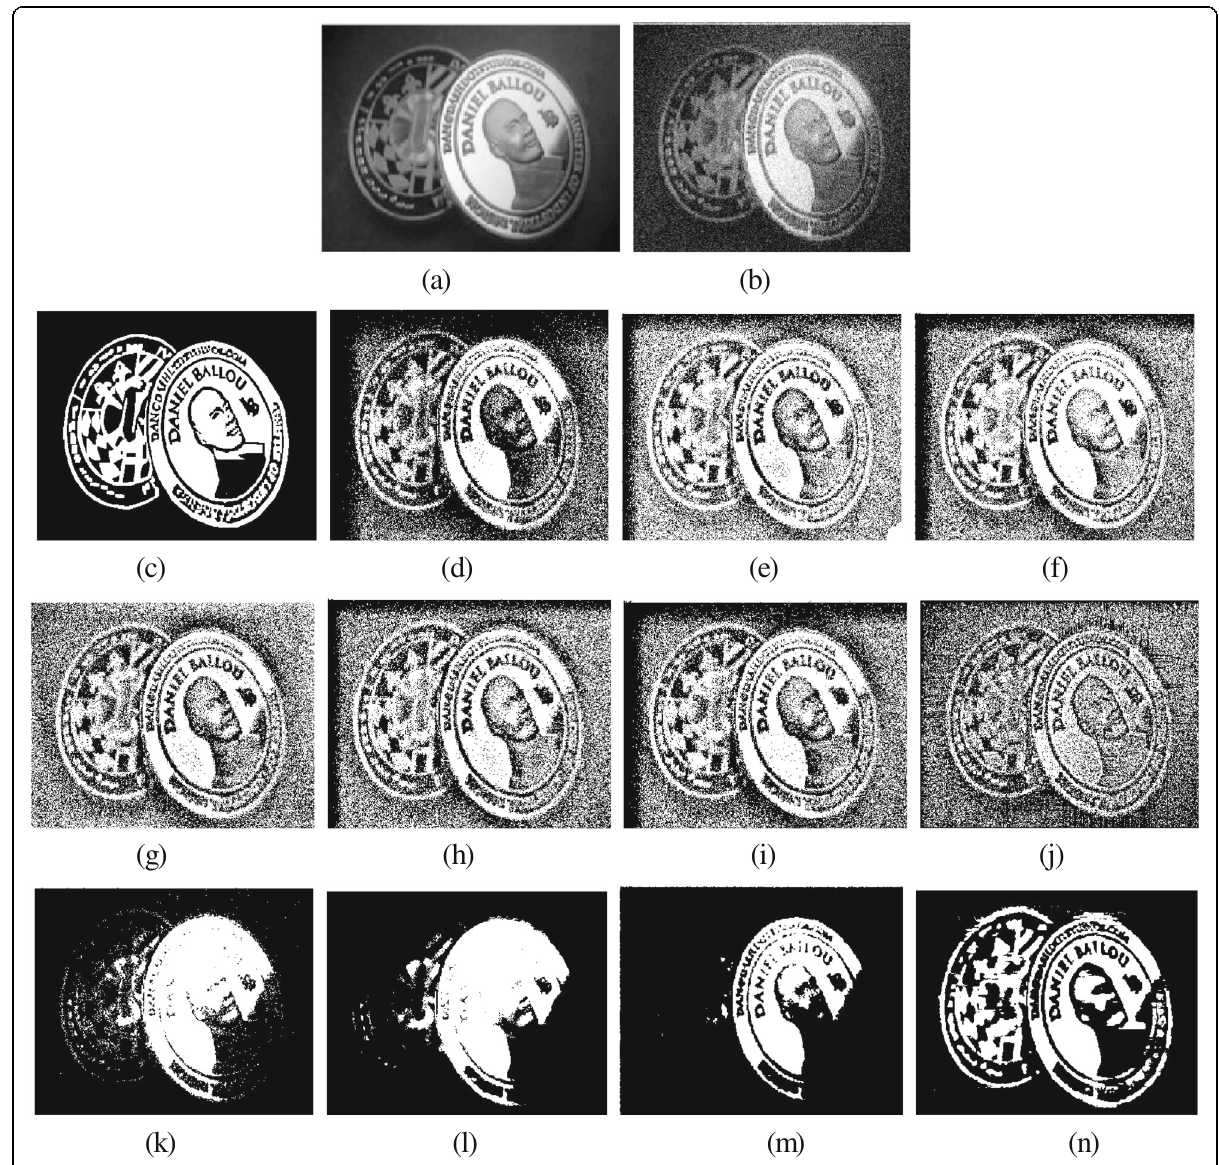
Fig. 13 Segmentation results on the coin image 280 × 393 corrupted by the Gaussian noise (0, 0.010). a Original image. b Noisy image. c Ground-truth. d Bernsen ’ s method. e Niblack ’ s method. f Sauvola ’ s method. g Bradley ’ s method. h Chou ’ s method. i Valizadeh ’ s method. j Wei ’ s method. k 2DOtsu. l FCM_NLS. m 2DWFPE. n Our method with T = 400, α =